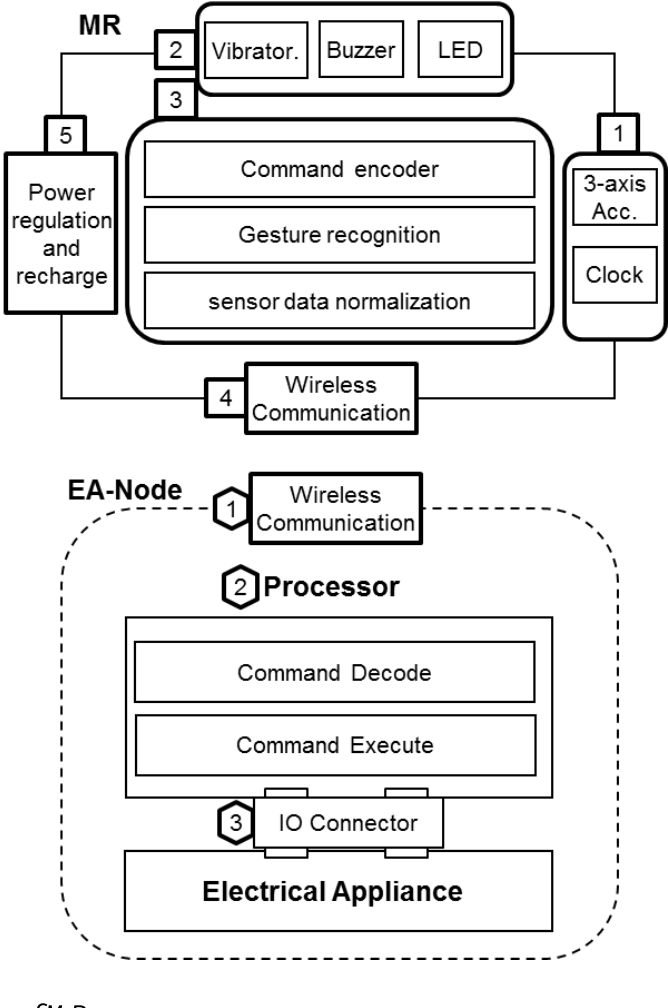
Figure 3. Structure of Magic Ring (MR) and EA-Node: two elements of finger-worn gestural